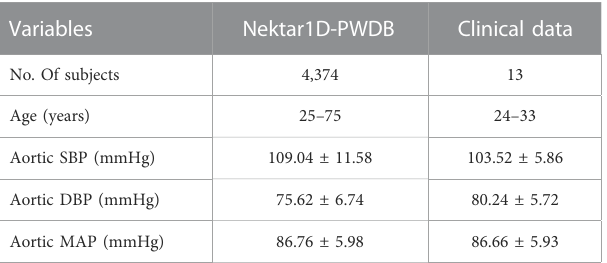
TABLE 1 The hemodynamic characteristics of the Nektar1D-PWDB and clinical data for all subjects. Shown as mean ± standard deviation (Mean ± SD).